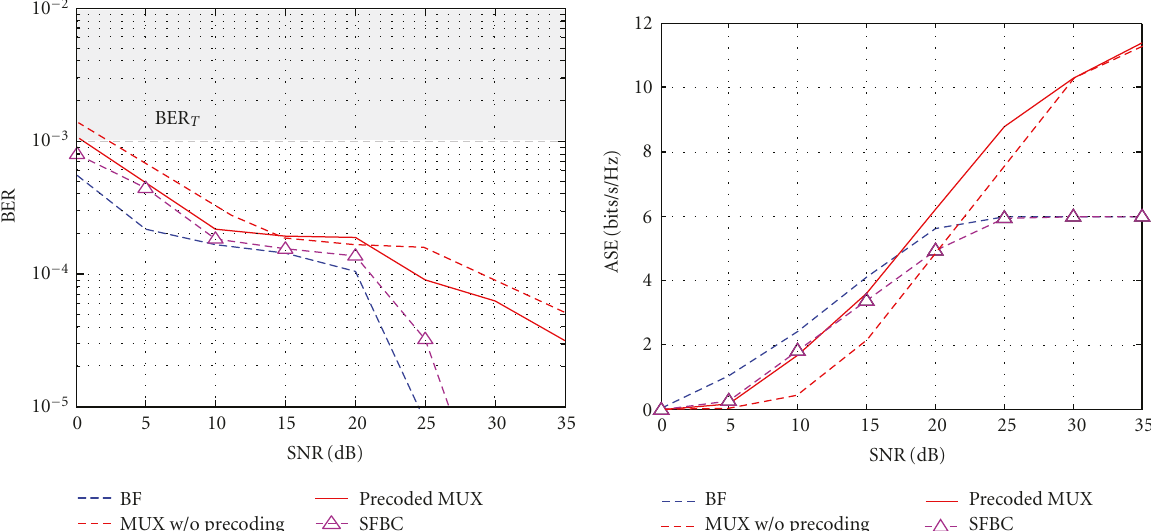
Figure 10: Average BER and ASE with adaptive modulation and BER T = 10 − 3 ( v = 3km/h, ρ = 0 .